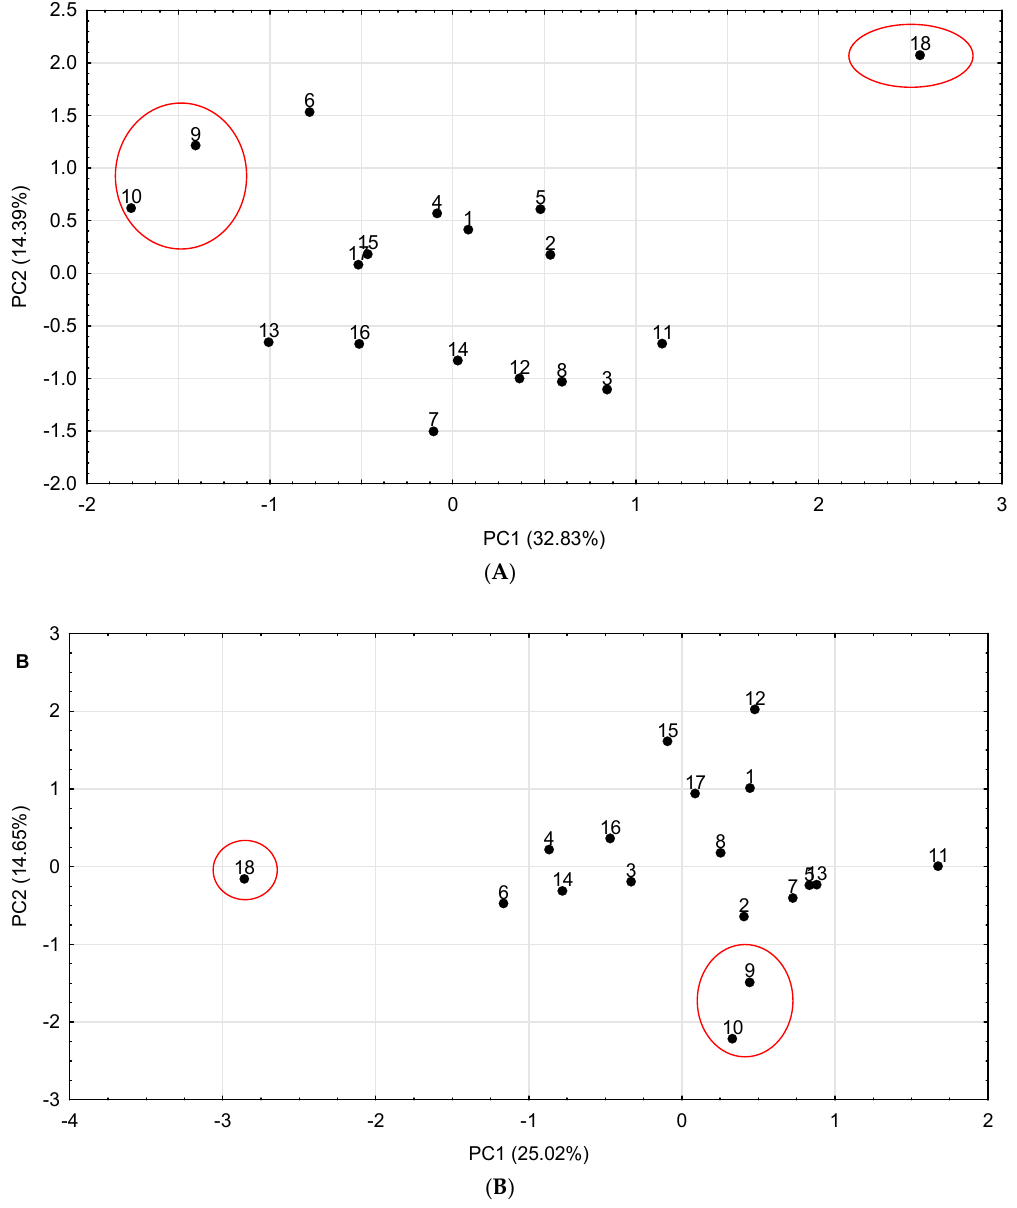
Figure 2. The principal component analysis score plot of the first two components for ( A ) hydromethanolic extracts and ( B ) water extracts of Morus alba